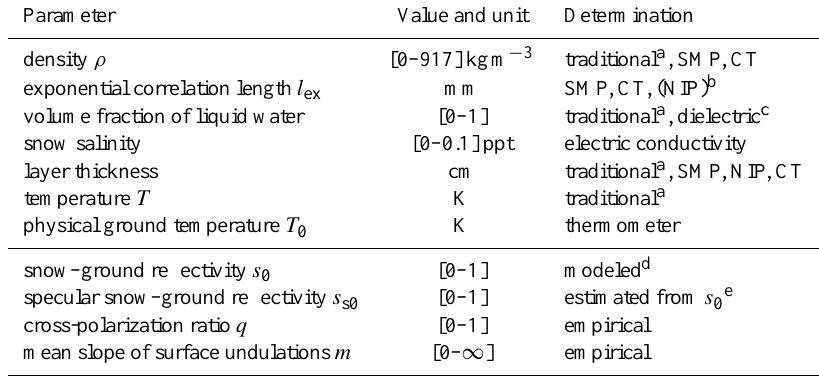
Table 1. Primary input parameters used in MEMLS3&a, with snow input parameters for each snow layer (upper part) and general model parameters (lower part). In addition, the value and unit of the parameter, as well as a typical way of determination, are indicated.